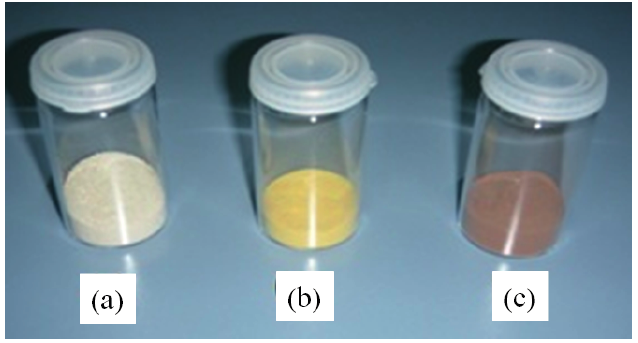
Figure 5. Color changes in the activated support after fixing of the organic molecules constituting the linker which allows the covalent attachment of lipases. From left to right are presented some pictures of ( a ) sepiolite/AlPO functionalized support after microwave heating with 4-aminobenzylamine; ( c ) functionalized support with